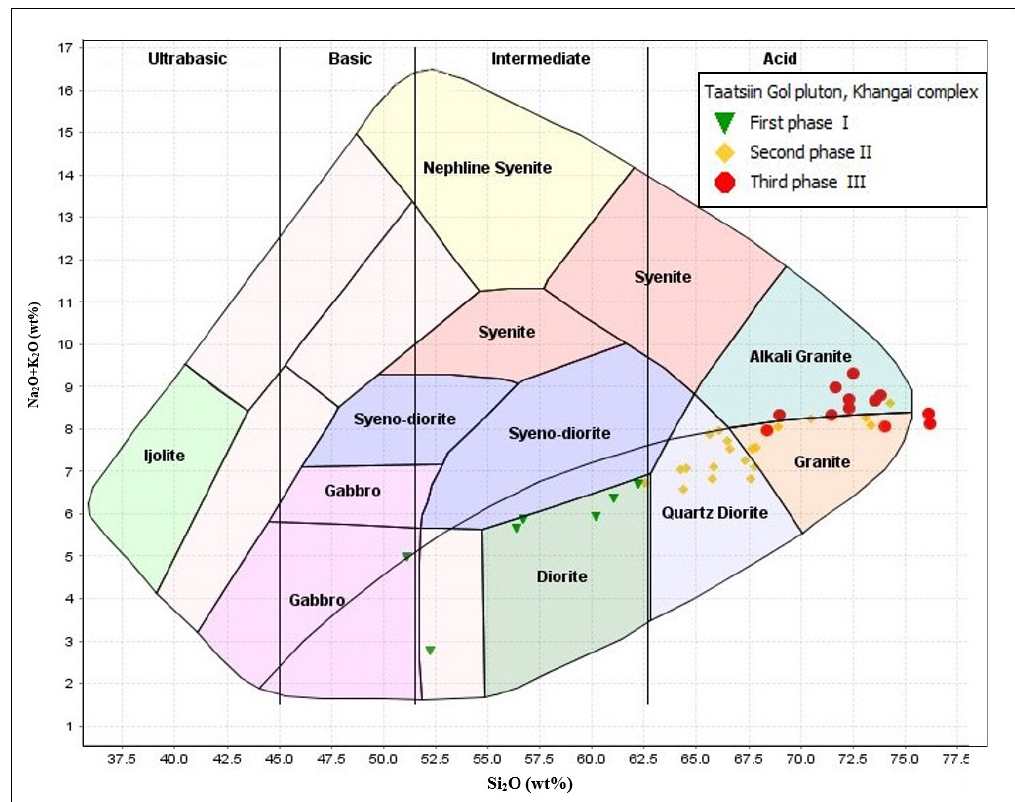
Fig 10. Total alkalis-silica (TAS) diagram for the Taatsiin Gol pluton